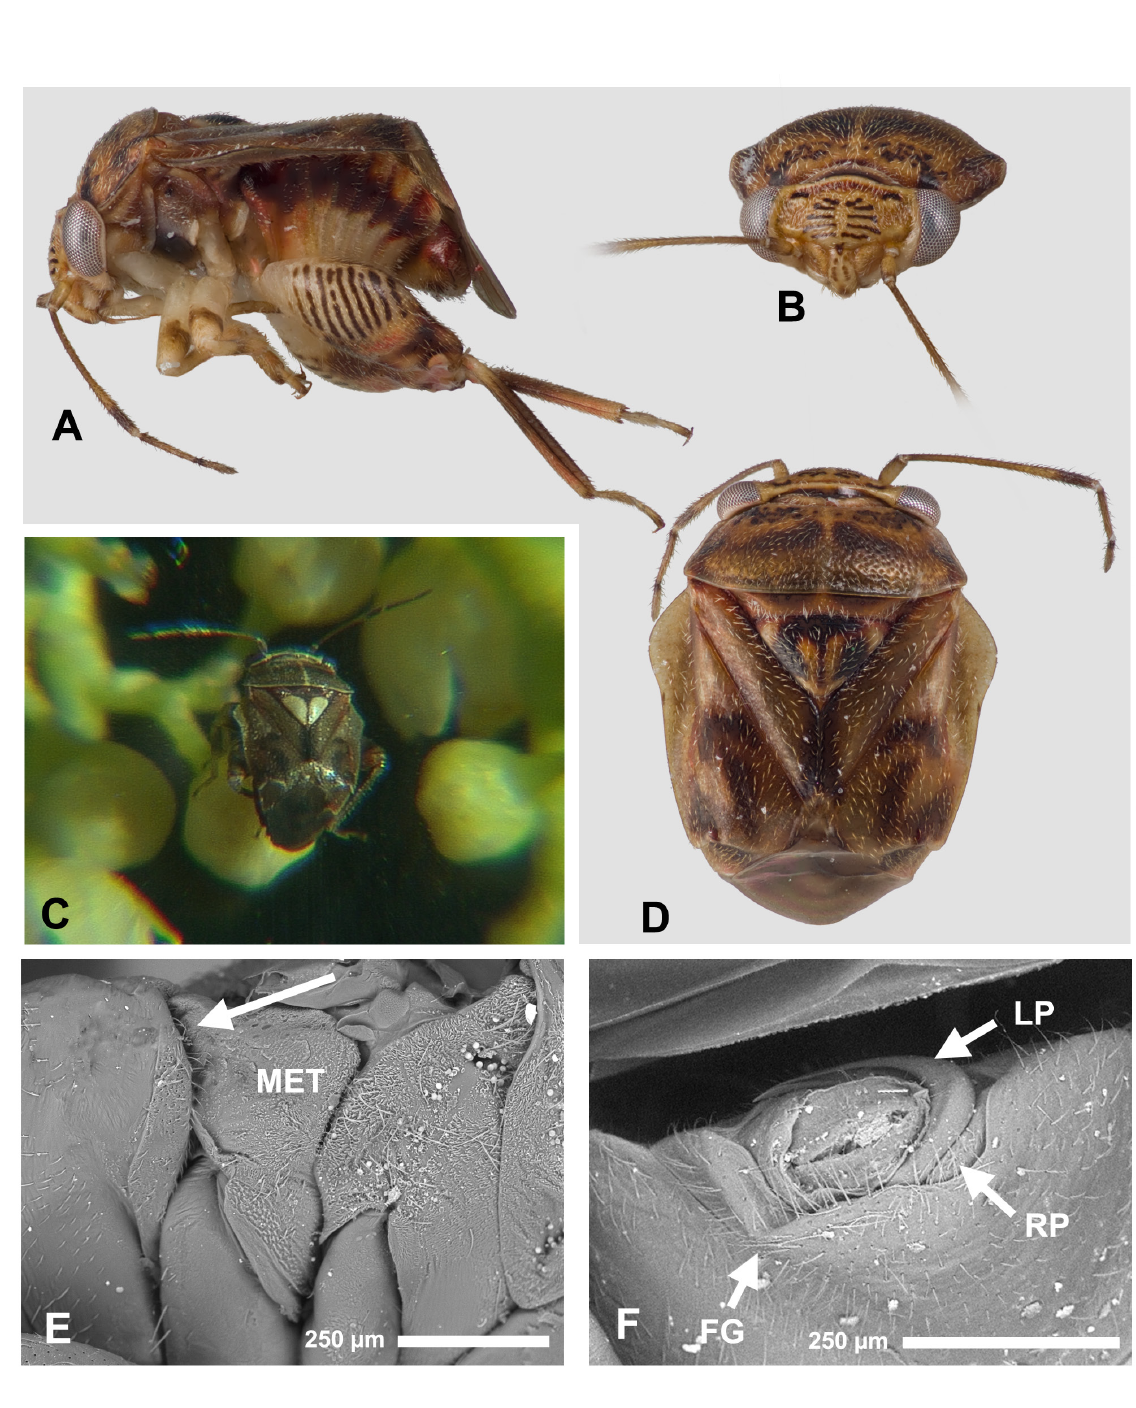
Fig. 5. Photographs and scanning electron micrographs of Coridromius norfolkensis sp. nov. A . Lateral view, ♂. B . Head and pronotum, anterior view, ♂. C . Photograph of C. norfolkensis sp. nov. (sex unknown) on Schinus terebinthifolius , showing alternate scutellum colouration. D . Dorsal habitus, ♂. E . Metathorax and anterior of abdomen, lateral view, ♀, arrow indicates site of insemination. F . ♂ genitalia, posterior view. FG = folded groove of pygophore, LP = left paramere, MET = metepimeral lobe, rP = right